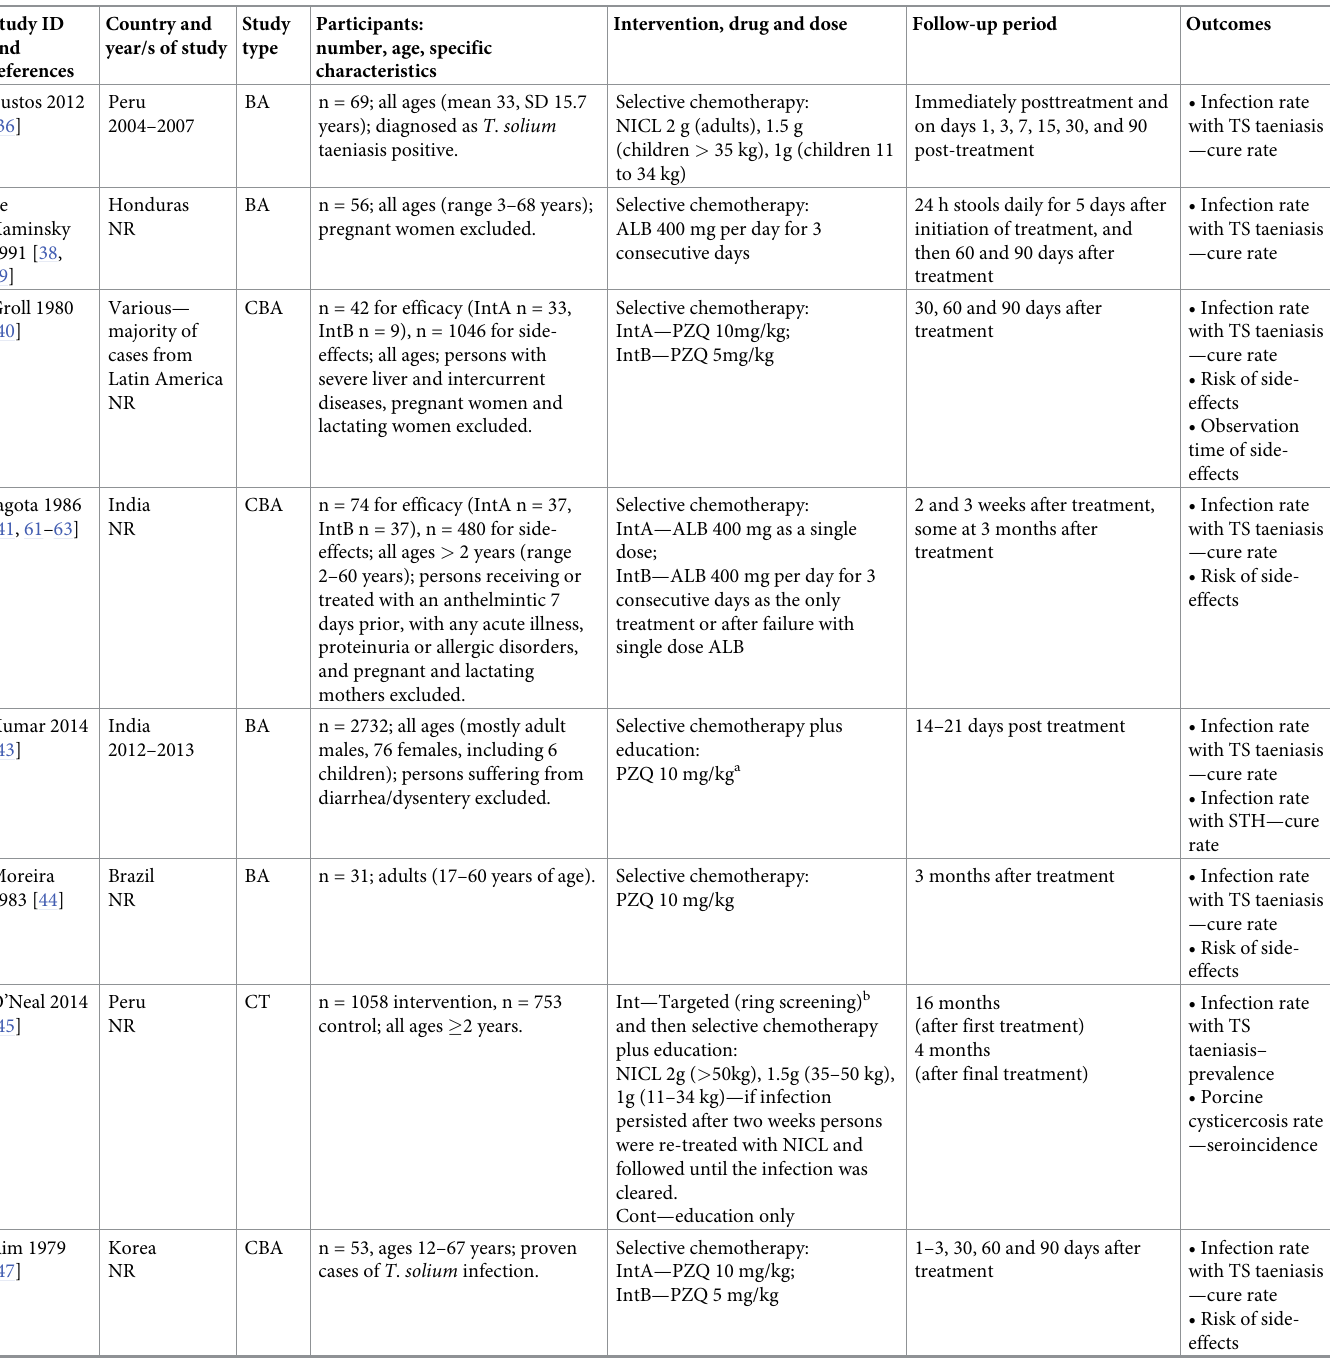
Table 2. Characteristics of included studies that tested selective chemotherapy (n =